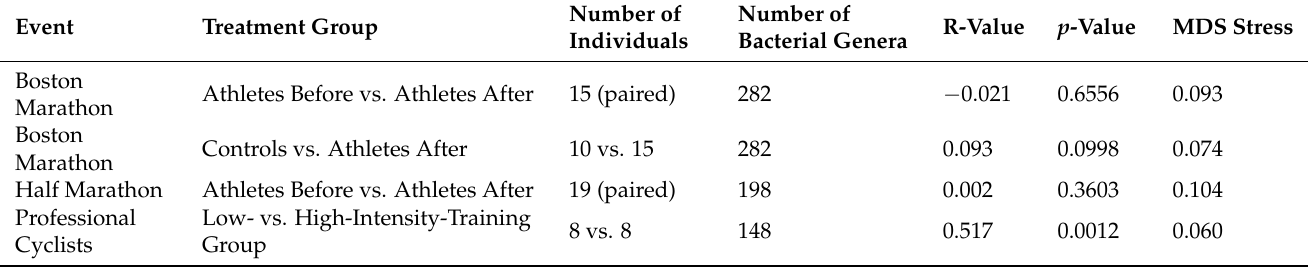
Table 2. ANOSIM results comparing overall differences between treatment groups for four datasets.